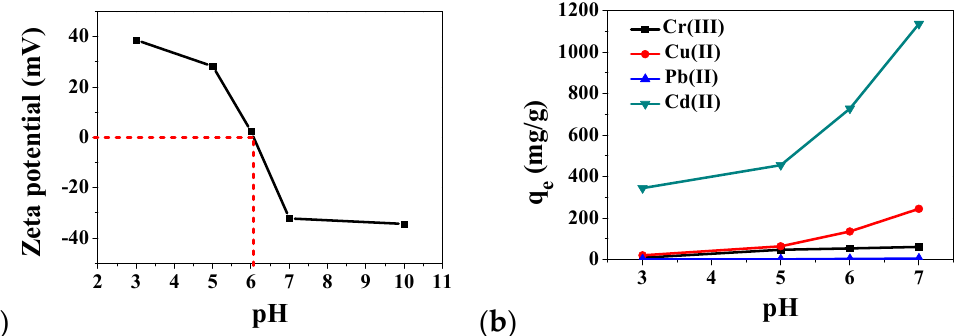
Figure 3. ( a ) Zeta potential of Fe 3 O 4 @Me 6 TREN NPs aqueous dispersion at various pH values; ( b ) the effect of pH on adsorption capacity for four metal ions by Fe 3 O 4 @Me 6 TREN NPs.